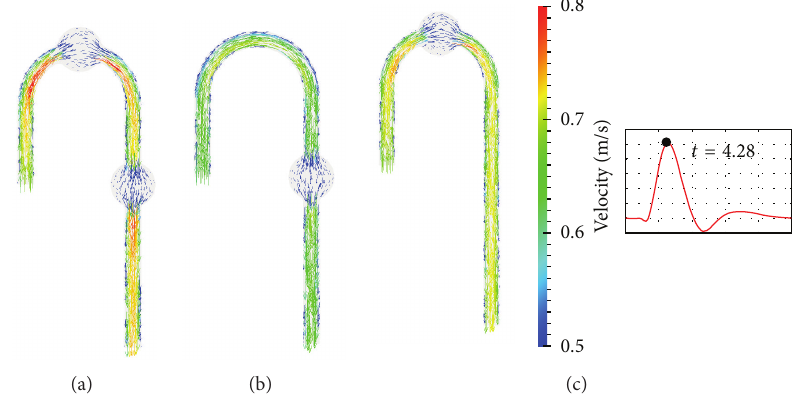
Figure 6: Peak velocity on DAA, TAA cured, and AAA cured middle plane DAA (a), TAA cured (b), and AAA cured (c).